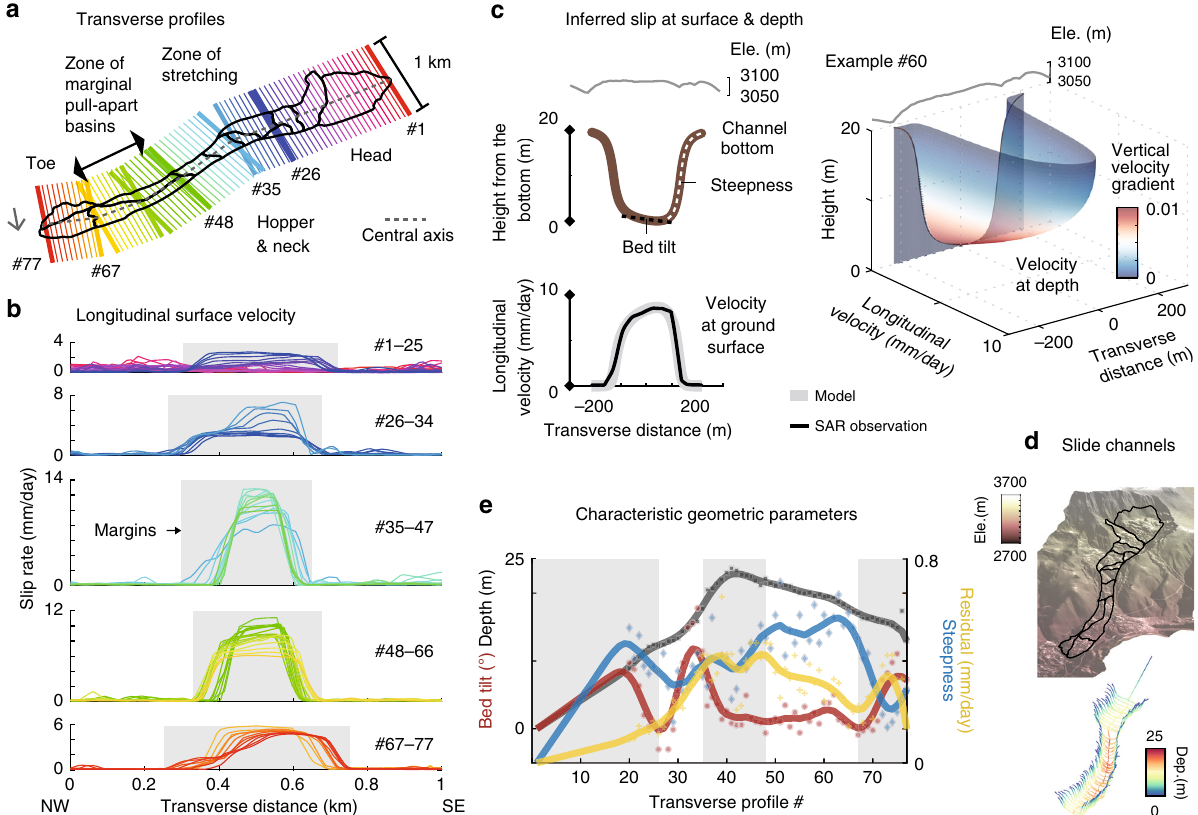
Fig. 2 Surface and subsurface landslide kinematics. a Transverse pro fi les from #1 to #77 selected every 50 m and differentiated by colors; the dashed gray line delineates the central axis. b Longitudinal surface velocity from hybrid InSAR-POT analysis of UAVSAR data; colored lines represent 1-km-long pro fi les in ( a ); the slip rate for fi ve structural zones is plotted separately with their corresponding pro fi le lines, and the orders of the colored lines are marked to the right; shaded sections are within the lateral margins determined by the velocity pro fi les. c Example of the inferred channel geometry and slip rates at the surface (compared with SAR results) and subsurface. Geometric steepness and bed tilt are indicated by white and black dashed lines, respectively. d 3D view of landslide surface and the inferred basal morphology. e Changing characteristic geometric parameters along the landslide. Symbols are the individual results for each pro fi le with fi tting lines in corresponding colors also used for y -axis